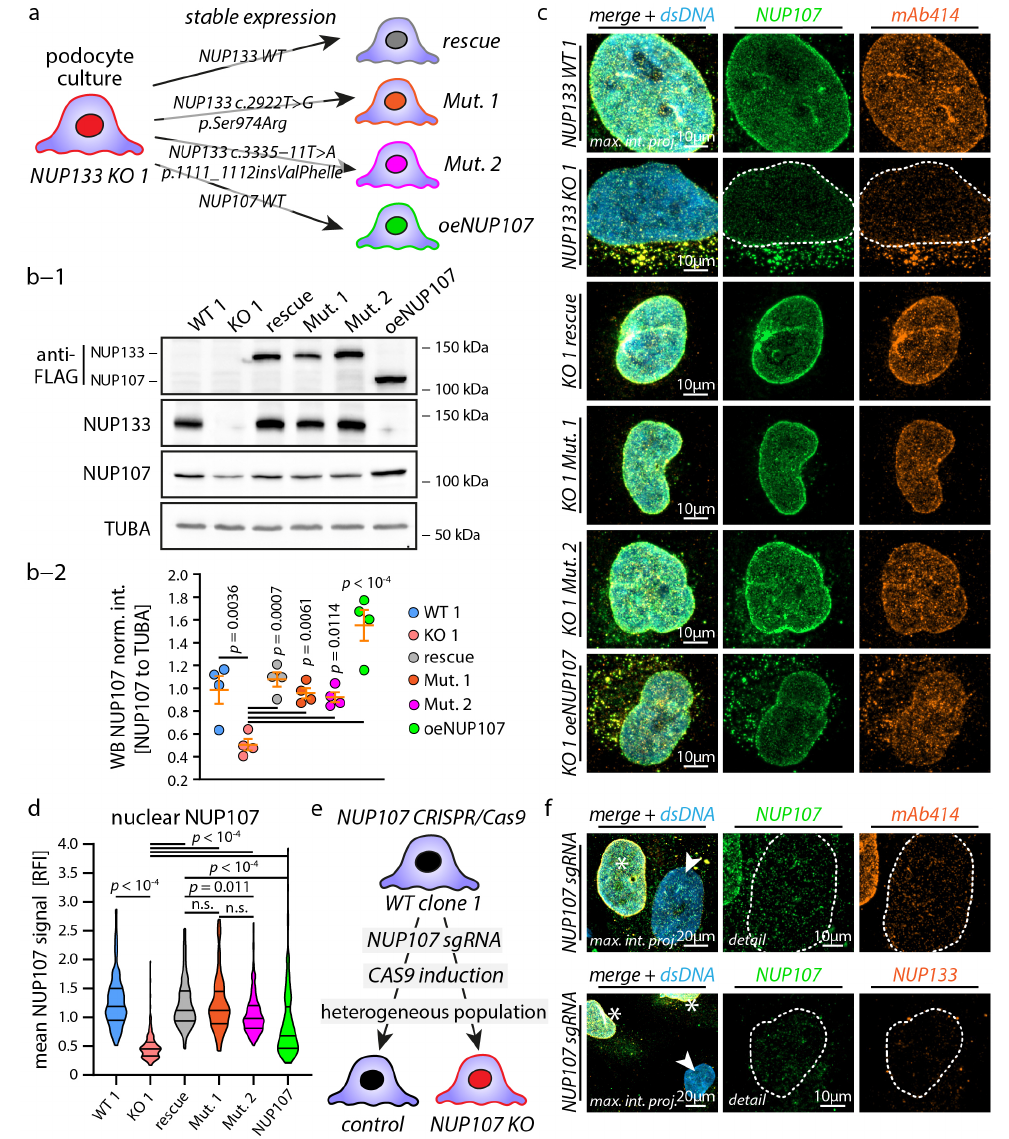
Figure 2. Causative NUP133 mutants restore Y-complex and NPC assembly. ( a ) Schematic depicting the generation of NUP133 WT (rescue), NUP133 mutant, and NUP107 overexpression (oeNUP107) cell lines by lentiviral transduction of NUP133 KO-1 podocytes. ( b-1 ) Western blot analysis confirms (re-)expression of FLAG-tagged NUP133 or NUP107 protein in KO podocytes and restored protein levels of endogenous NUP107. Alpha-tubulin (TUBA) was used as loading control. ( b-2 ) The NUP107-to-TUBA western blot band densities of four independent replicates were analyzed (scatterplot). ( c , d ) Immunofluorescence analysis of mature NPCs in the nuclear envelope by NUP107 and mAb414 staining (nuclei were co-stained by Hoechst 33342; dotted lines indicate the nuclear circumference; maximum intensity projections of z-stacks from whole nuclei are shown). Nuclear NUP107 staining signals were quantified by measurements of relative fluorescence intensities (RFI) from at least 147 cells, per genotype, from one representative experiment, and expressed as violin plots. ( e , f ) Schematic illustrating the generation of an inducible NUP107 KO podocyte population by CRISPR/Cas9 genome editing. Immunofluorescence analysis of this heterogeneous population of NUP107 KO podocytes by NUP107, NUP133, and mAb414 demonstrated severely impaired formation of NPCs in KO cells (white asterisks indicate cells with preserved and white arrowheads with lost NUP107 expression; dotted lines indicate the nuclear circumference; maximum intensity projections of z-stacks from whole nuclei are shown; n.